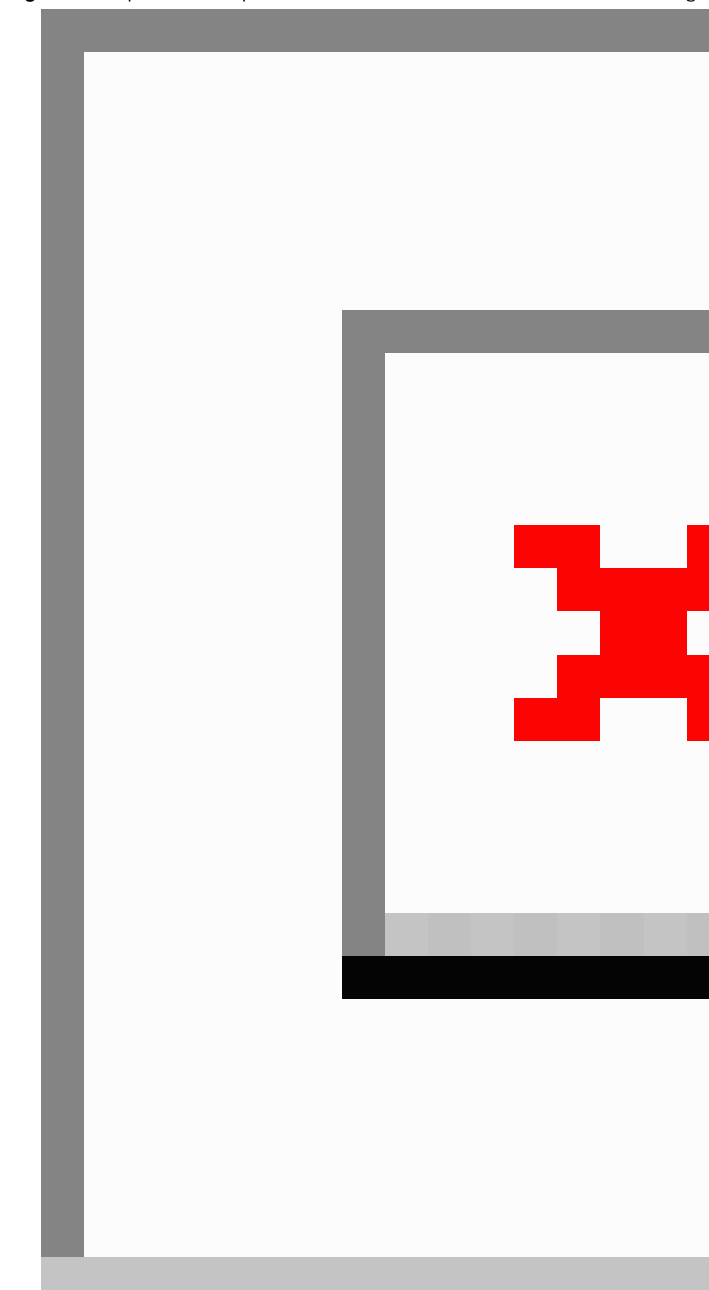
Figure 2. Proportion of respondents interested in individual telehealth technologies by patient